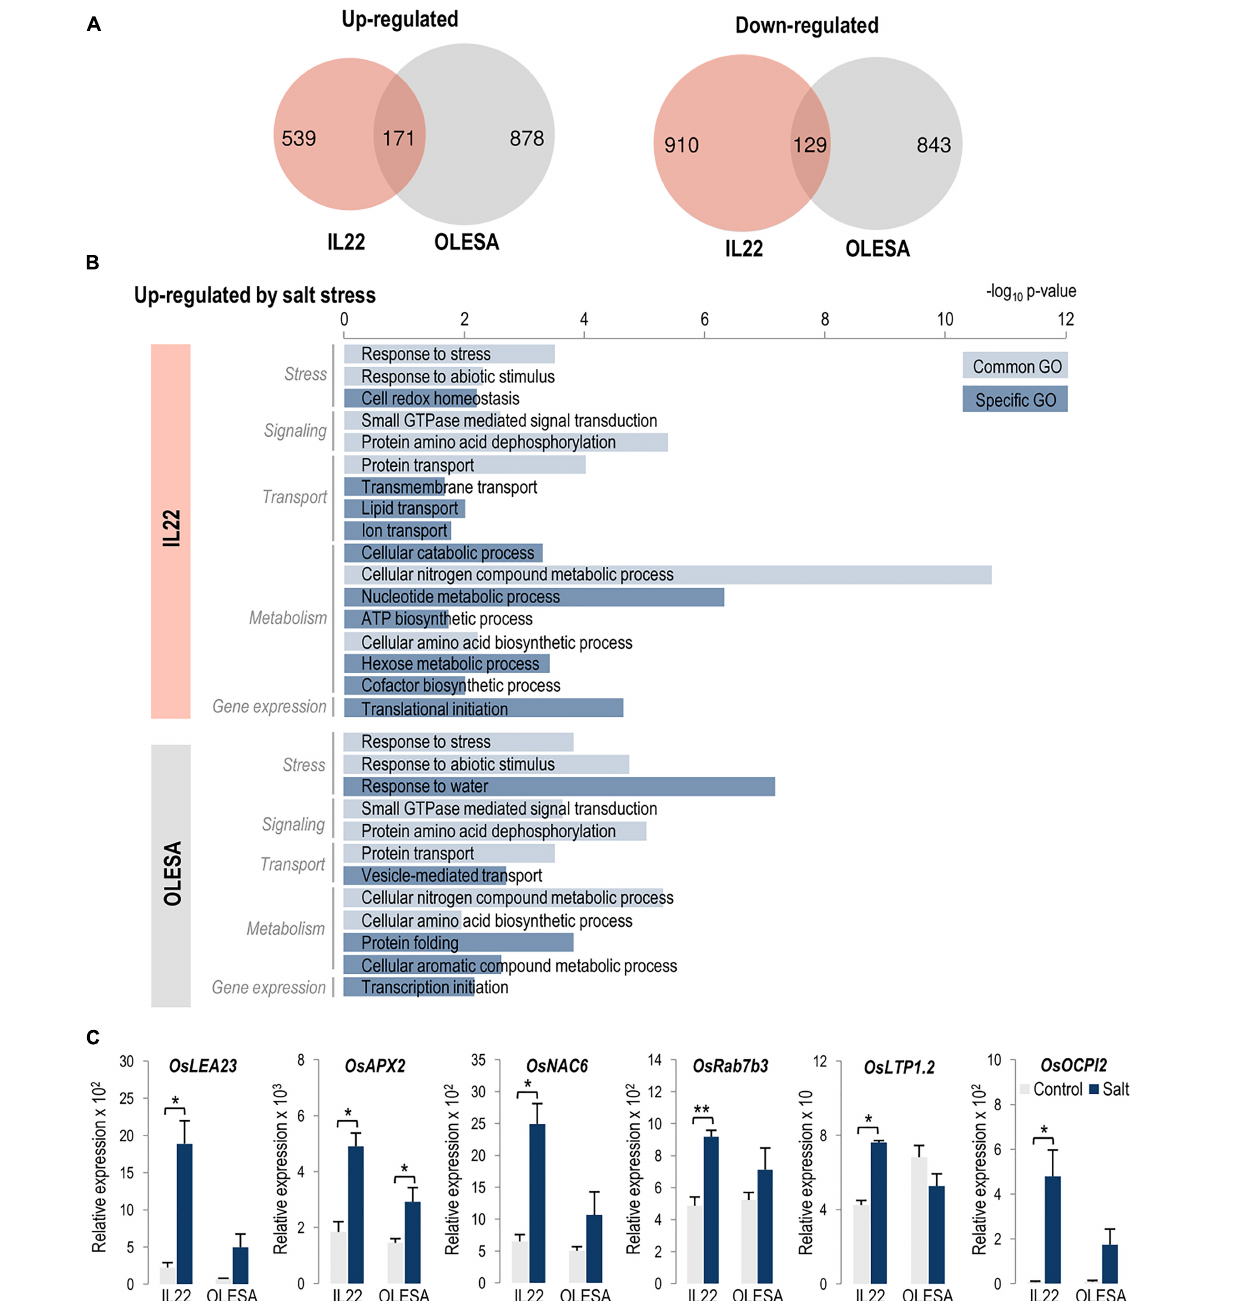
Frontiers in Plant Science |